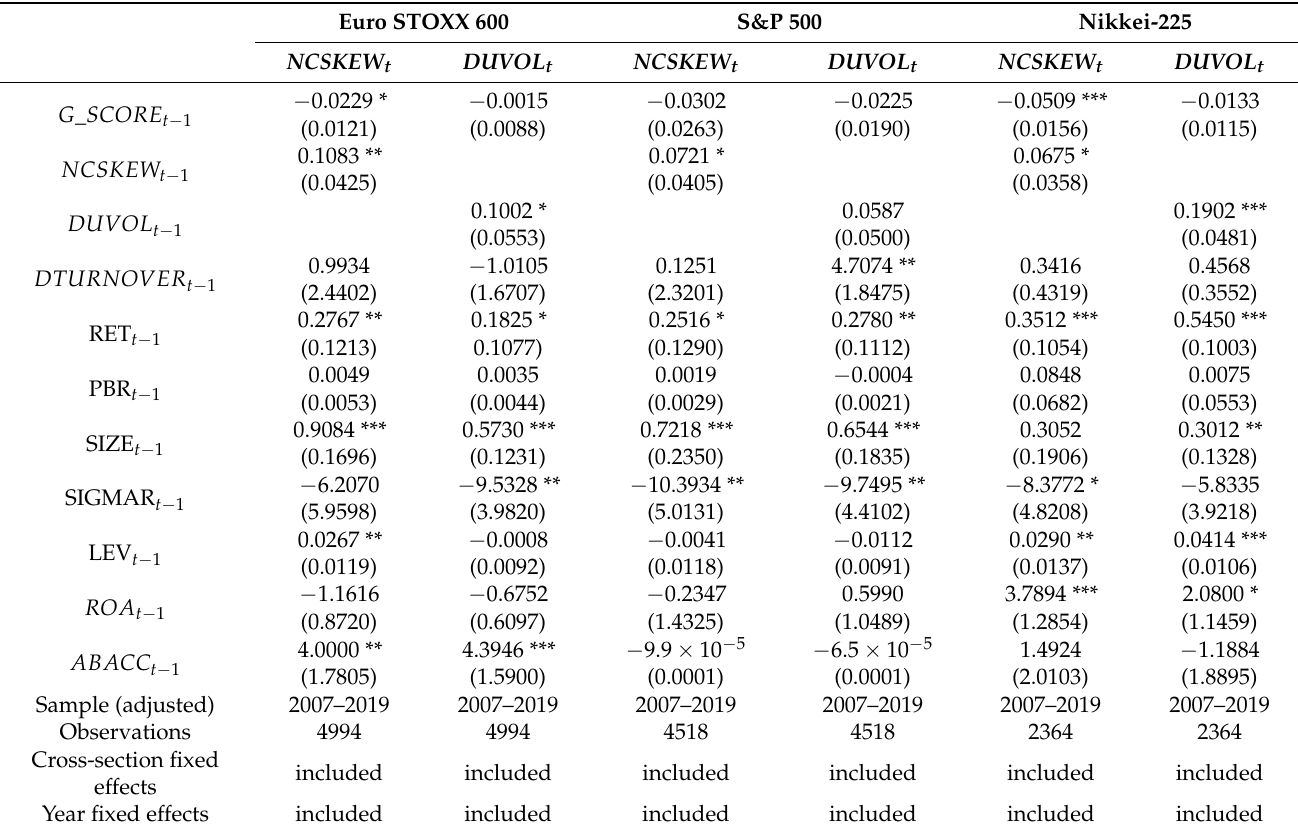
Table 9. Regression analysis on the effect of governance disclosure on crash risk using dynamic panel